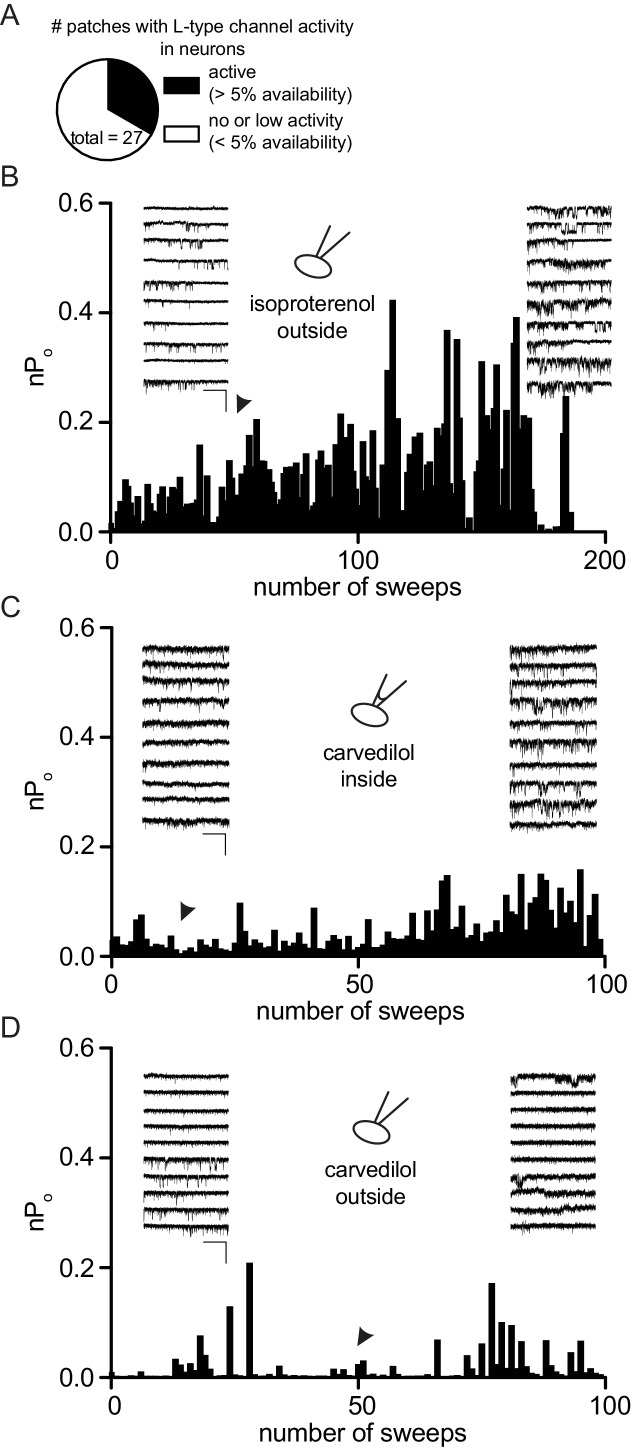
Over-time effect of carvedilol on LTCC of neurons recorded in the cell attached configuration without using BayK.Cells were depolarized with 110 mM Ba2+ for 2 s from a holding potential of −80 mV to 0 mV and the NPopen was determined over time. (A) Diagram reflecting our patch statistics without using BayK in the recording pipette. Only about 30% of our patches showed channel activity. Cells with >5% channel availability within the first 50 sweeps were considered for our analysis. Cells with <5% availability were consequently excluded for pharmacological testing. (B) Control experiment demonstrating the effect of 1 µM isoproterenol applied through bath perfusion (n = 11 cells). (C) Over-time effect of 1 µM carvedilol applied through backfilling of the recording pipette (n = 8 cells). Tip filling was performed with pipette solution containing no carvedilol. (D) Experiment showing the effect of 1 µM carvedilol perfused into the bath solution (n = 8 cells).